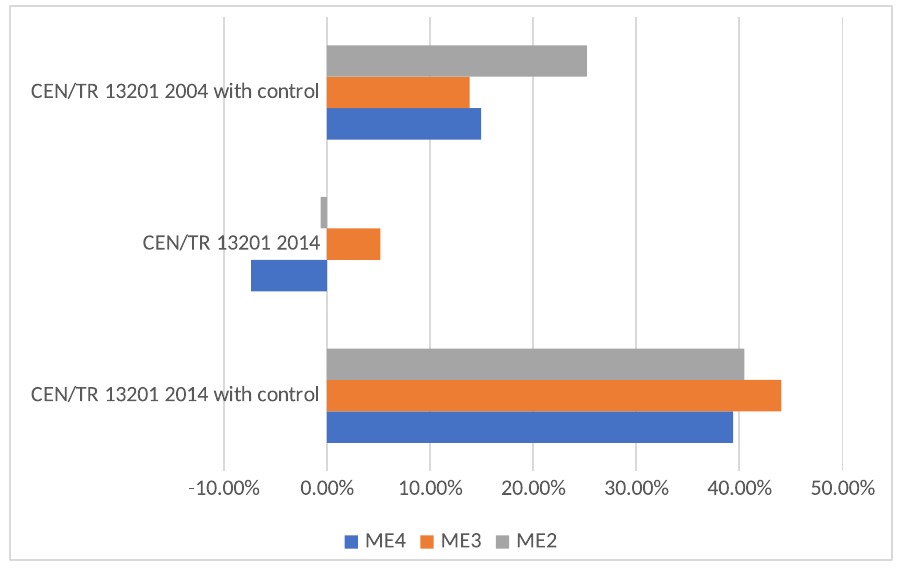
Figure 5. Energy savings with dynamic control for the normal classes.